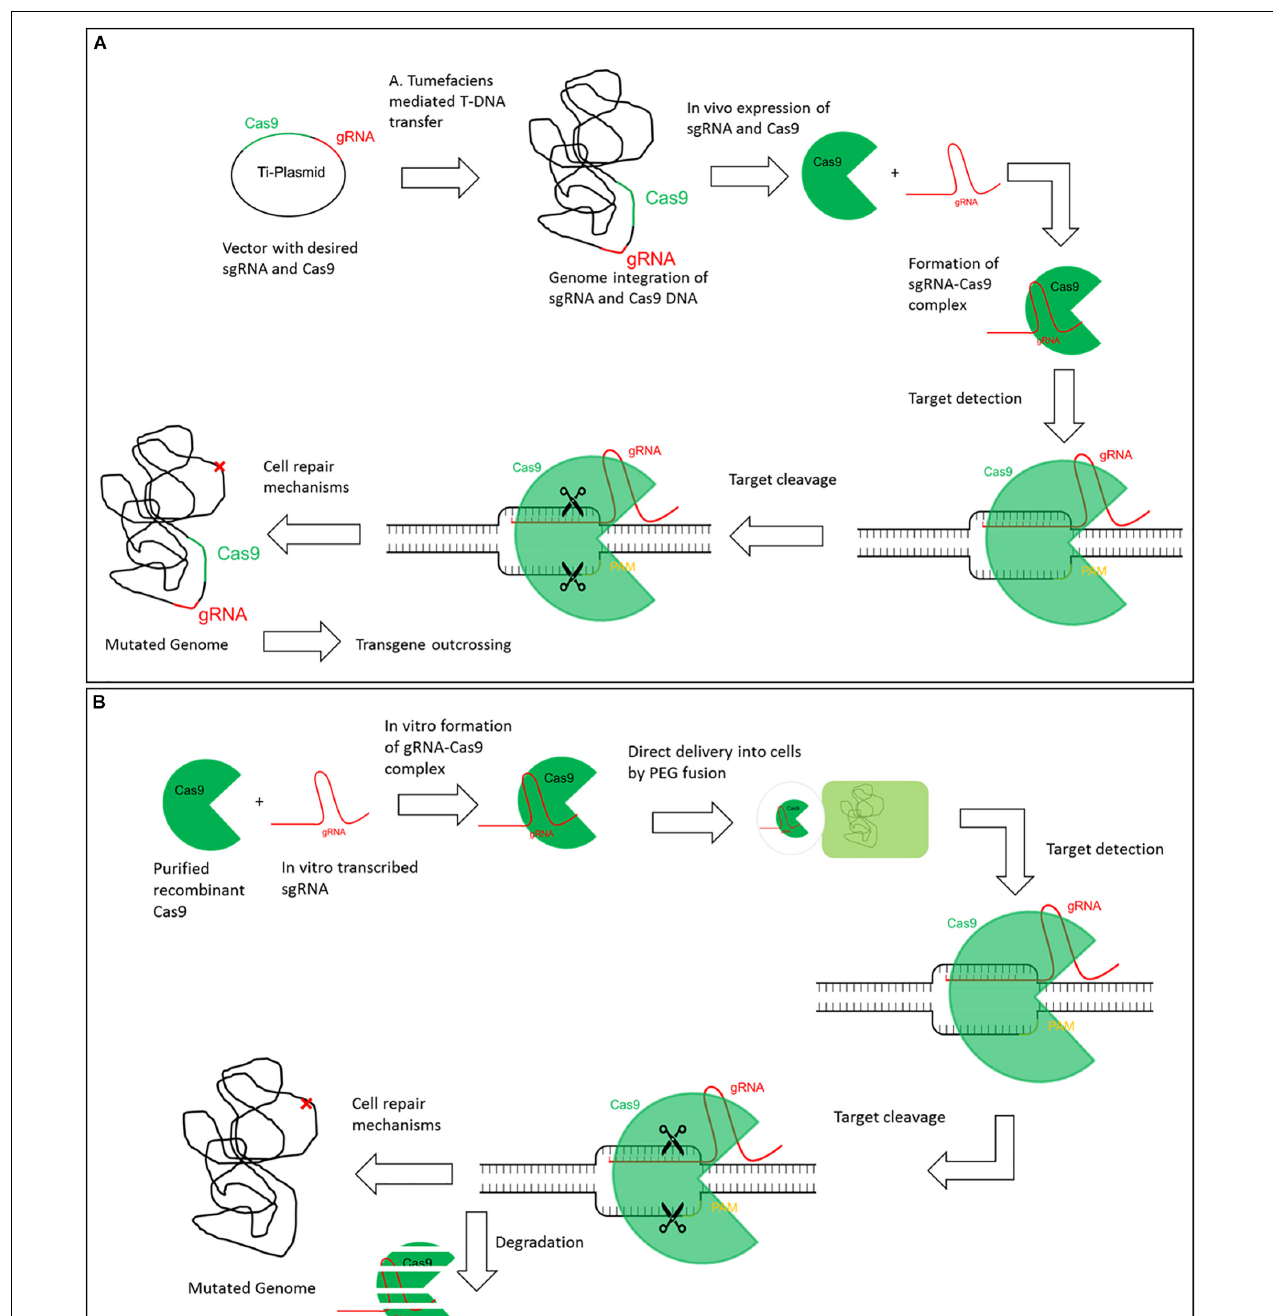
FIGURE 1 | Exemplary comparison of classic CRISPR/Cas9 and DNA-free CRISPR/Cas9. Comparison of classic CRISPR/Cas9 through the example of (A) . tumefaciens transformation and DNA-free CRISPR/Cas9 exemplified by PEG mediated protoplast fusion. (A) In the classic CRISPR/Cas9 technique a T-Plasmid is designed that includes the desired gRNA and Cas9 coding sequences. Via Agrobacterium tumefaciens mediated transfer both gRNA and Cas9 sequences can be integrated in the host genome. In vivo gRNA and Cas9 are translated and the gRNA-Cas9 RNP complex is formed. Upon target detection, a double strand break is induced and mutations can arise by internal cell repair mechanisms. The CRISPR/Cas9 complex is constantly expressed and active in the cell. Finally, the genome can contain both the desired mutation and sequences for gRNA and Cas9. The transgene can be outcrossed but this is less practical or even impossible in vegetative propagated crops. (B) For DNA-free CRISPR/Cas9 recombinant Cas9 and in vitro translated gRNA are required. The RNP complex is formed in vitro and is directly delivered to protoplasts by e.g., PEG fusion. The complex is already active and can directly detect its target to induce double strand breaks. Cell repair mechanisms can lead to a mutated genome at the desired target without addition of any foreign DNA. The CRISPR/Cas9 complex is degraded within the cell and no longer available.